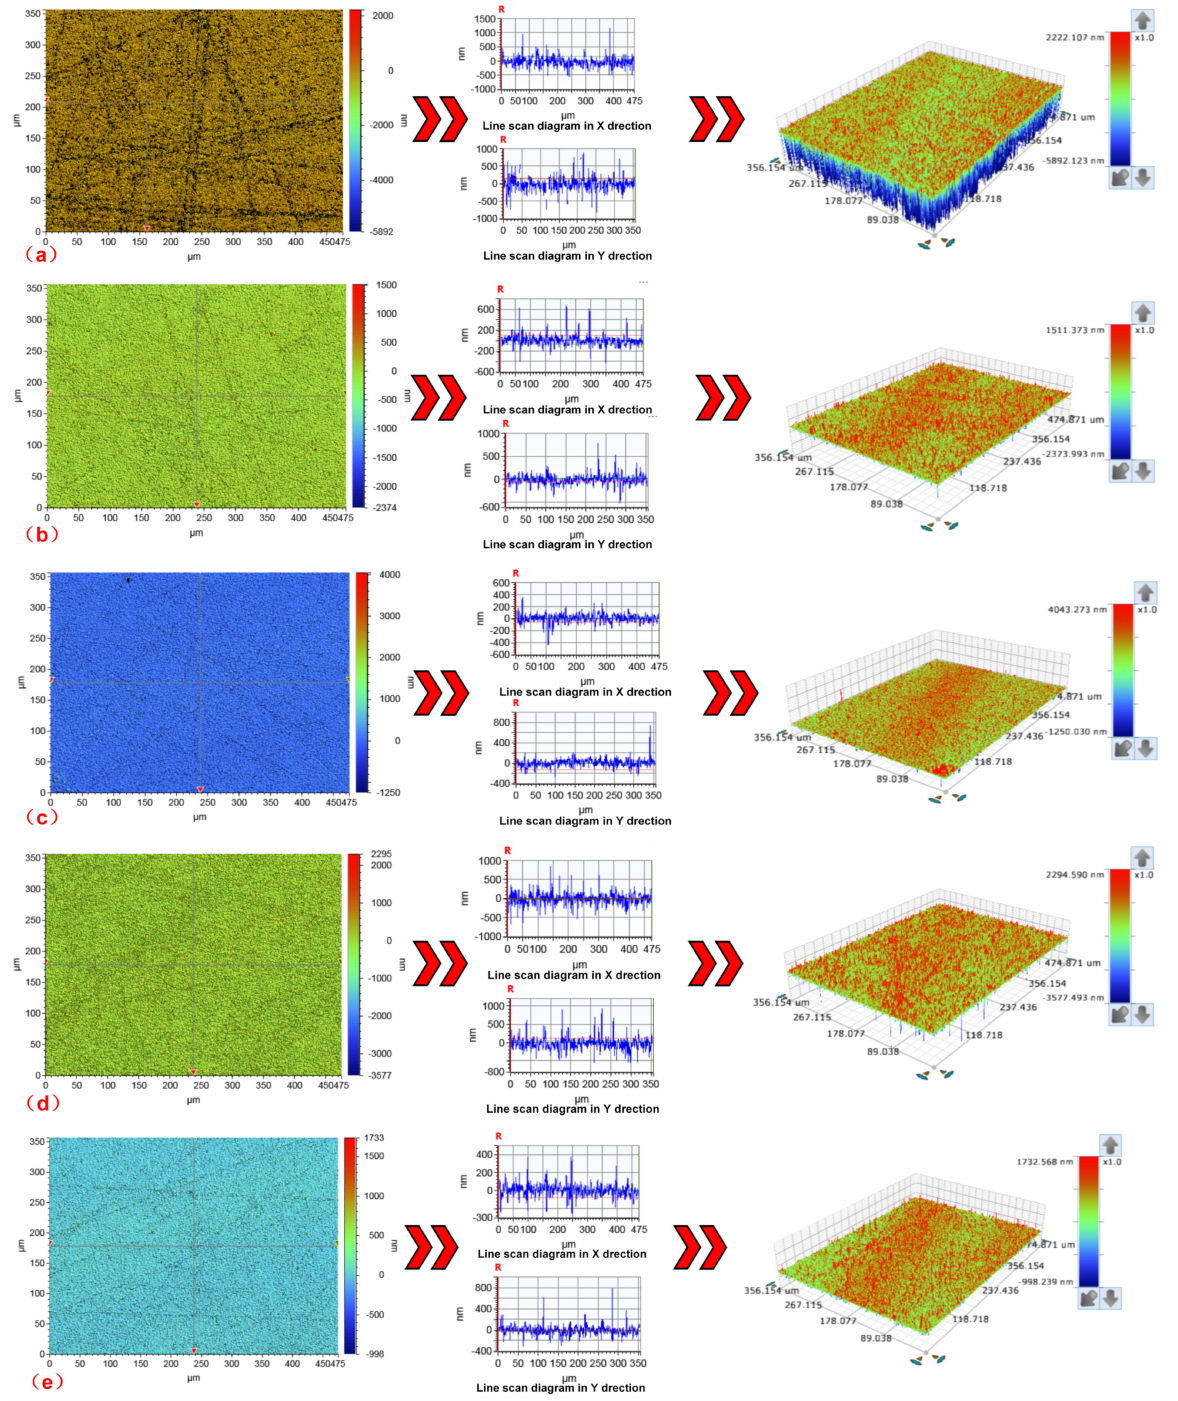
Figure 5. The surface morphology of the first processing of quartz glass by FAP using different process parameters: ( a ) the surface morphology of the quartz glass processed by the blunt FAP; ( b ) the surface morphology of experiment No. 1 quartz glass; ( c ) the surface morphology of experiment No. 4 quartz glass; ( d ) the surface morphology of experiment No. 8 quartz glass; ( e ) the surface morphology of experiment No. 15 quartz